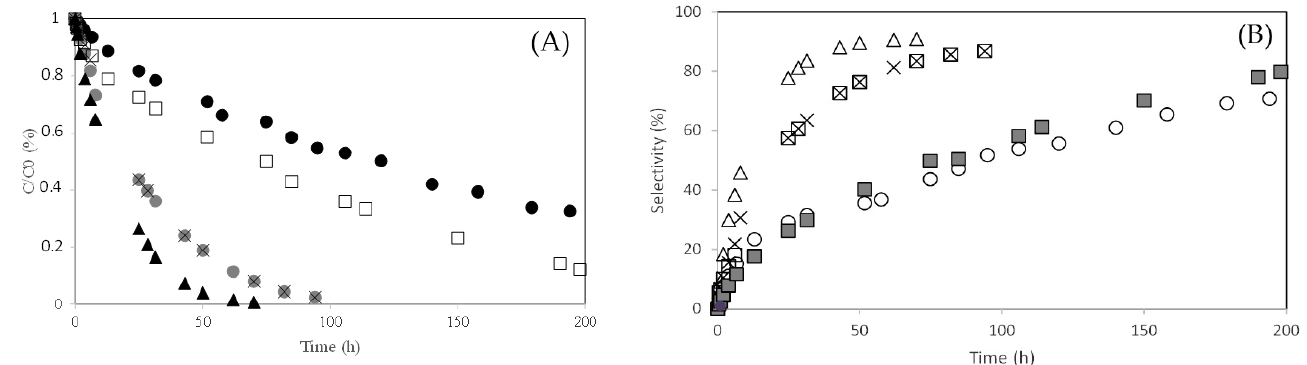
Figure 10. Hydration of camphene over PW4-SBA-15-SO 3 H catalyst. Effect of the catalyst amount. ( A ) Camphene conversion (%) versus time (h): ( ) m = 0.48 g; ( ) m = 0.30 g; ( ) m = 0.10 g; Isoborneol selectivity (%): ( ) m = 0.48 g; ( ) m = 0.30 g; ( ) m = 0.10 g. ( B ) Camphene conversion (%) and selectivity (%) to the isoborneol at 70 h of reaction.